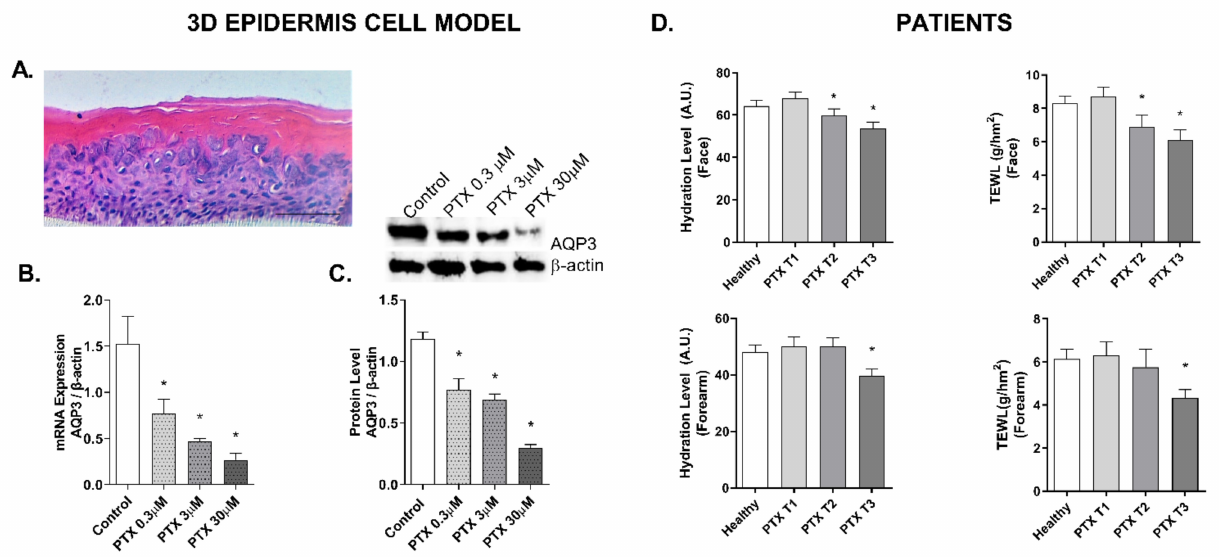
Figure 1. Paclitaxel induces a dose-dependent loss of hydration levels in oncologic patients and reduces the expression of the hydration marker AQP3 in the 3D epidermal cell model. ( A ) Paraf- fin section from the 3D epidermis model stained with hematoxylin and eosin. Scale bar 100 µ m. ( B ) Three-dimensional epidermal cell model tissues were incubated for 24 h with increasing paclitaxel (PTX) concentrations. Aquaporin (AQP3) mRNA levels were measured by real-time PCR. Data are expressed as 2 − ∆ Ct . ( C ) Three-dimensional epidermal cell model tissues were incubated for 24 h with increasing paclitaxel (PTX) concentrations. AQP3 protein levels were analyzed by Western blotting. Quantification was performed by densitometry and normalized to β -actin. Results are expressed as the mean ± standard deviation of two independent experiments ( n = 3); * p < 0.05 vs. control. Uncropped Western Blots can be found at Supplementary File. ( D ) Hydration levels were measured in 20 oncologic patients before (T1), during (T2), and after (T3) treatment with PTX, and in 20 healthy subjects as a control group. Measurements were conducted with Corneometer CM 825 ® in the cheekbone and forearm. Transepidermal water loss (TEWL) levels were measured in 20 oncologic patients before (T1), during (T2), and after treatment (T3) with PTX, and in 20 healthy subjects as a control group. Measurements were conducted with Tewameter TM 300 ® in the cheekbone and forearm. Results are expressed as the mean ± standard deviation of at least 3 measurements each time ( n = 20); * p < 0.05 vs.